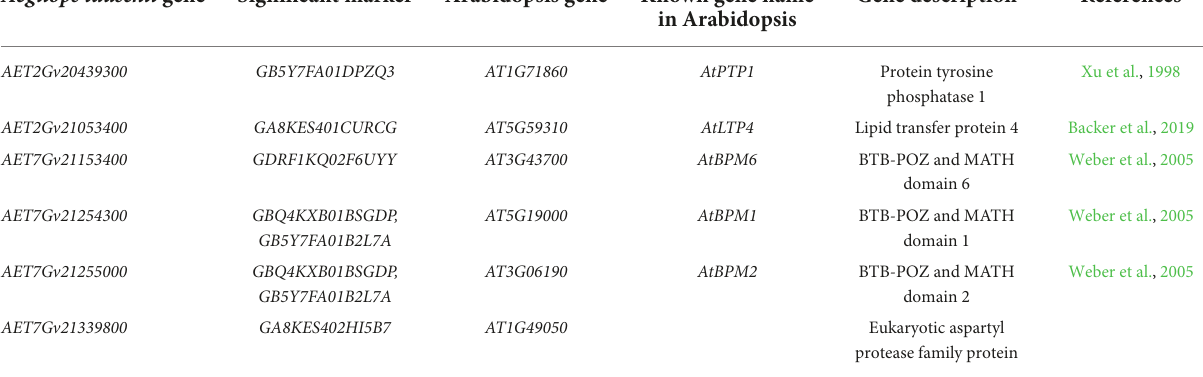
TABLE 5 Candidate genes associated with Fusarium crown rot